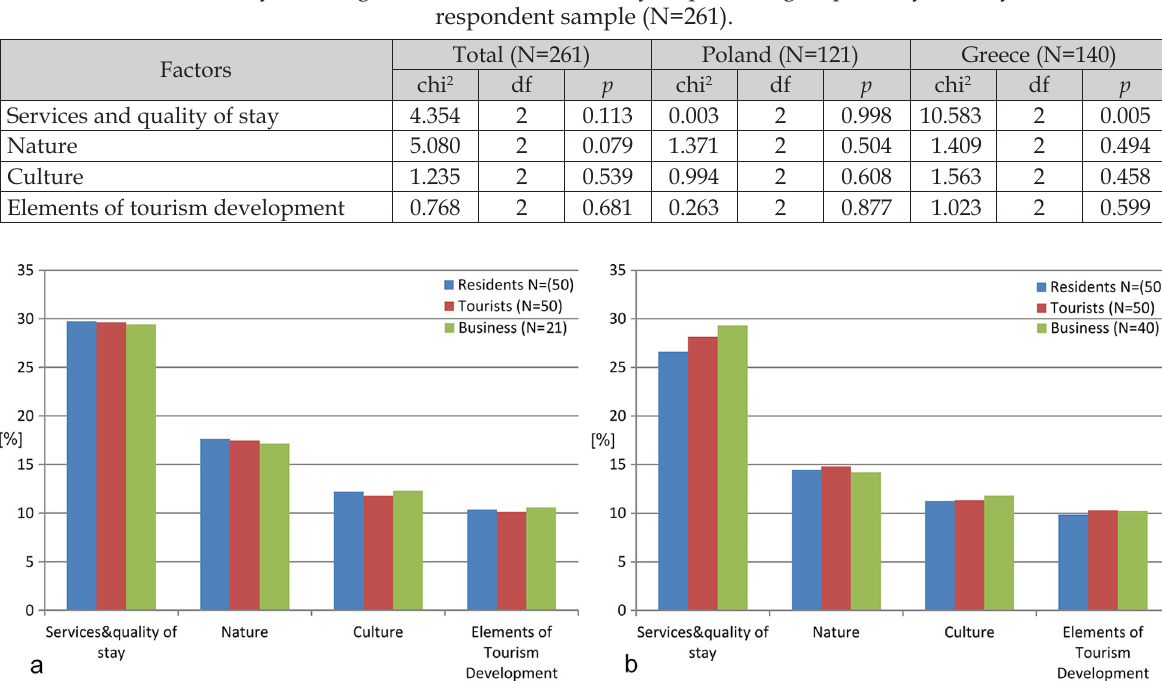
Services and quality of stay